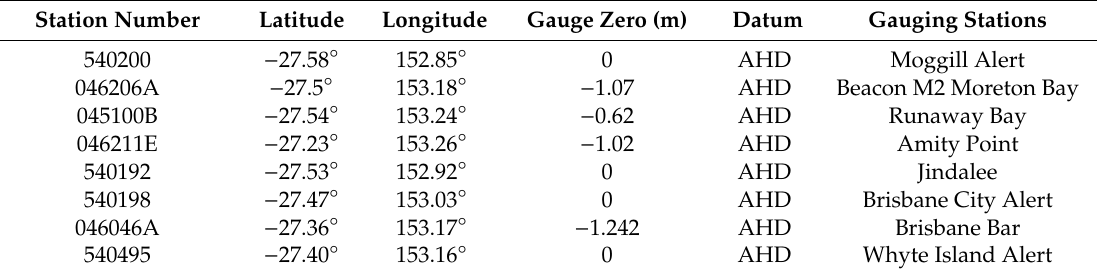
Table 2. Model boundary condition data, calibration and validation gauge name, and